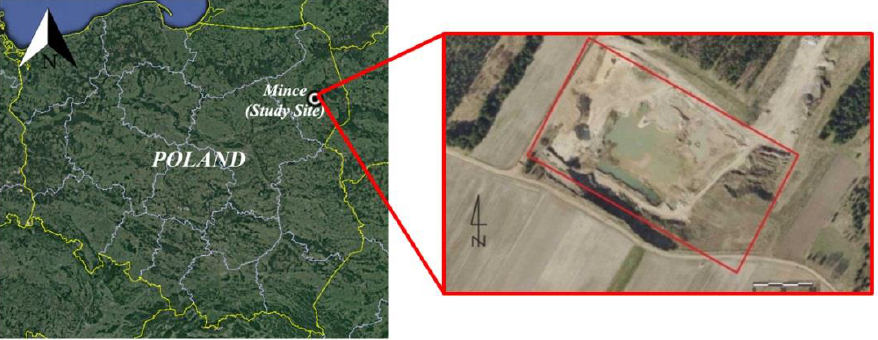
Figure 5. The study site.